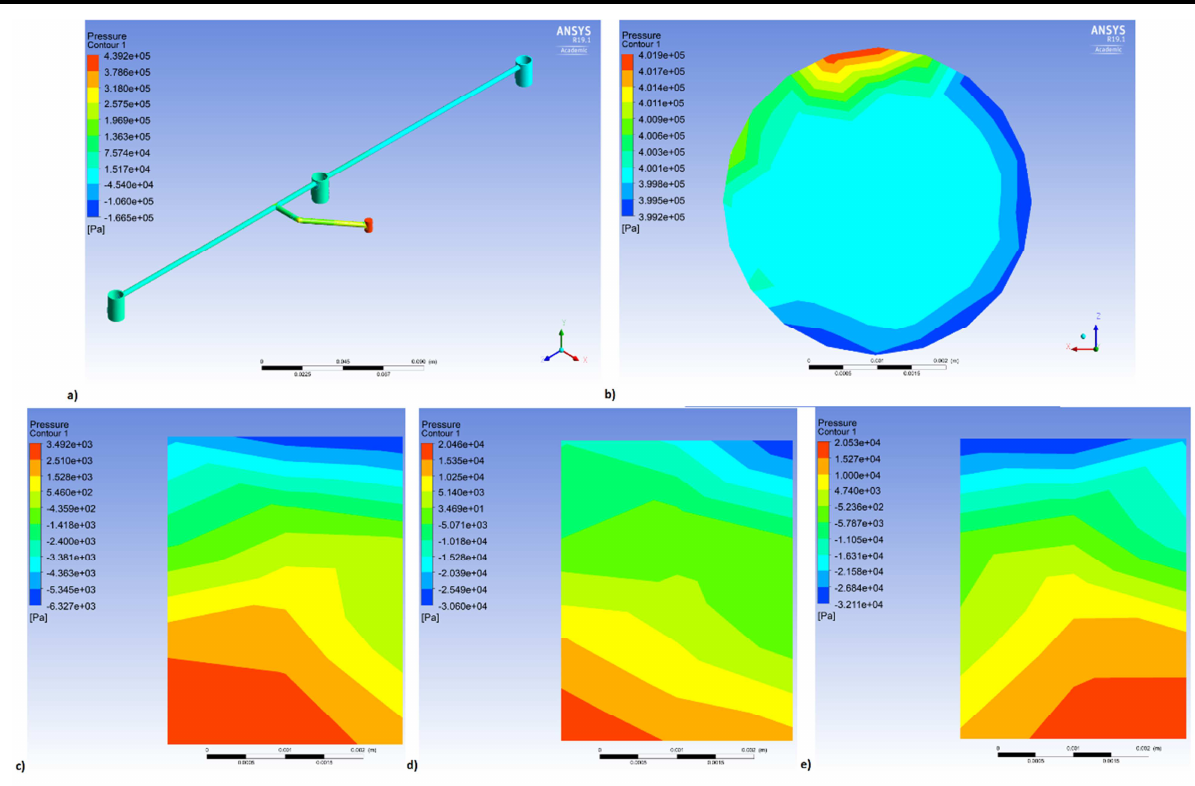
Fig. 9. The oil pressure distribution for the boundary condition on the inlet in the form of mass flow 0.00035 kg/s, a) for the oil main line, b) at the inlet, c) at the Outlet1, d) at the Outlet2, e) at the Outlet3